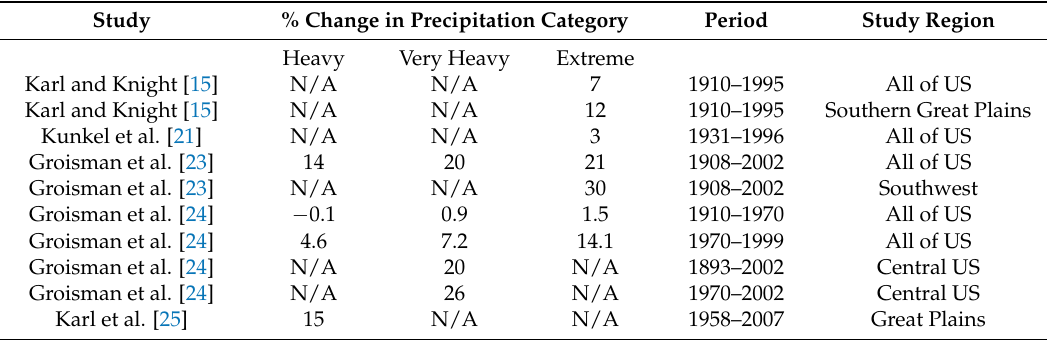
Table 2. Trends (negative for decreasing and positive for increasing) in intense precipitation categories quantified by the mentioned